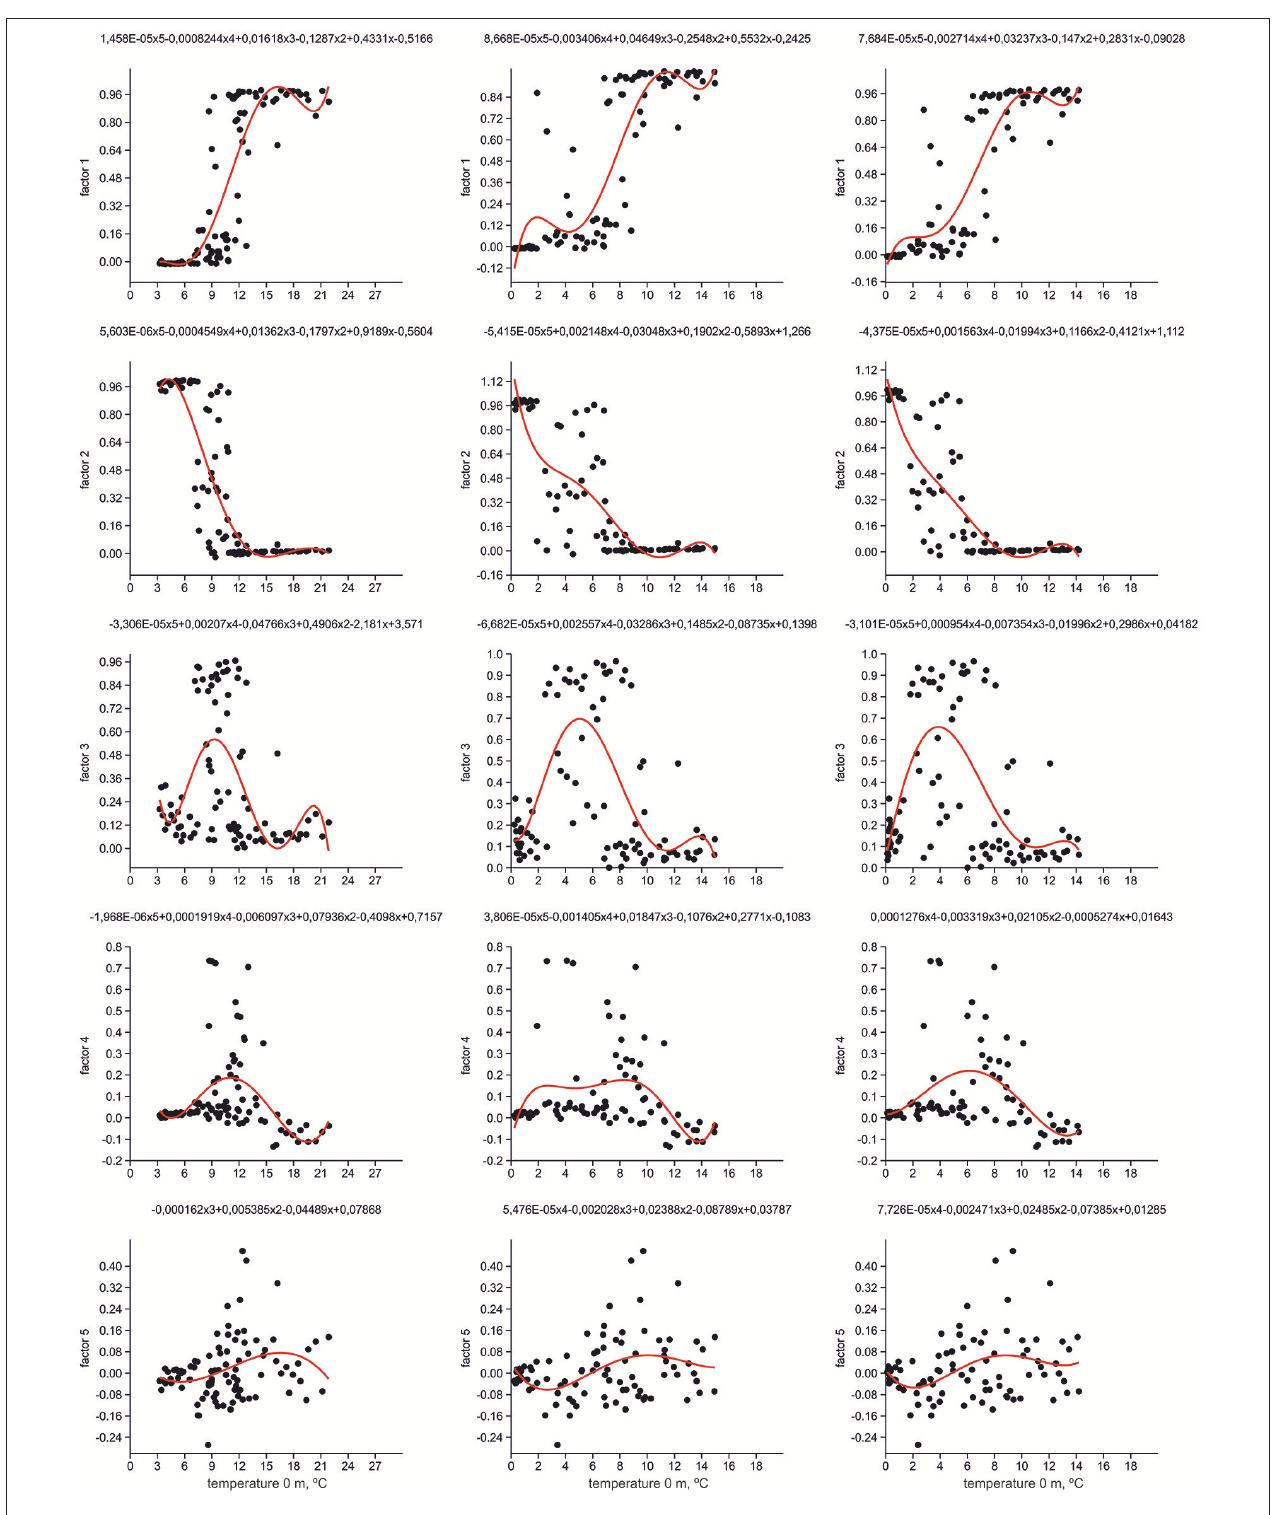
FIGURE 6 | Distribution of factor loadings against temperature. Polynomial equations and functions (red line) are shown.